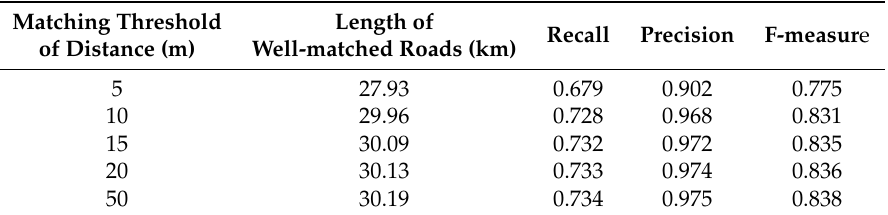
Table 2. Matching results of our method on the Chicago dataset.